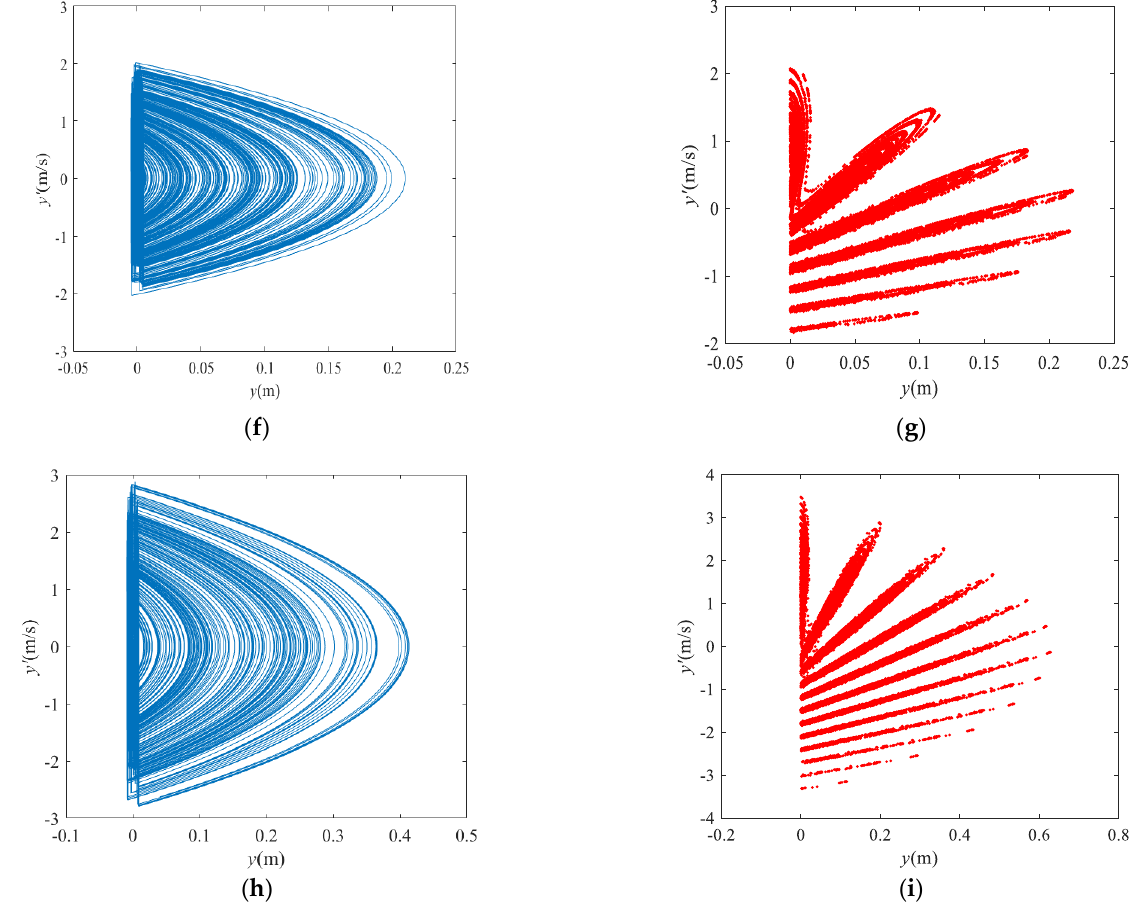
Figure 4. Nonlinear behavior of a particle at different amplitudes: ( a ) Bifurcation diagram of different amplitudes; ( b ) Phase diagram at A = 1 mm; ( c ) Poincaré map at A = 1 mm; ( d ) Phase diagram at A = 1.5 mm; ( e ) Poincaré map at A = 1.5 mm; ( f ) Phase diagram at A = 5 mm; ( g ) Poincaré map at A = 5 mm; ( h ) Phase diagram at A = 9 mm; ( i ) Poincaré map at A = 9 mm.